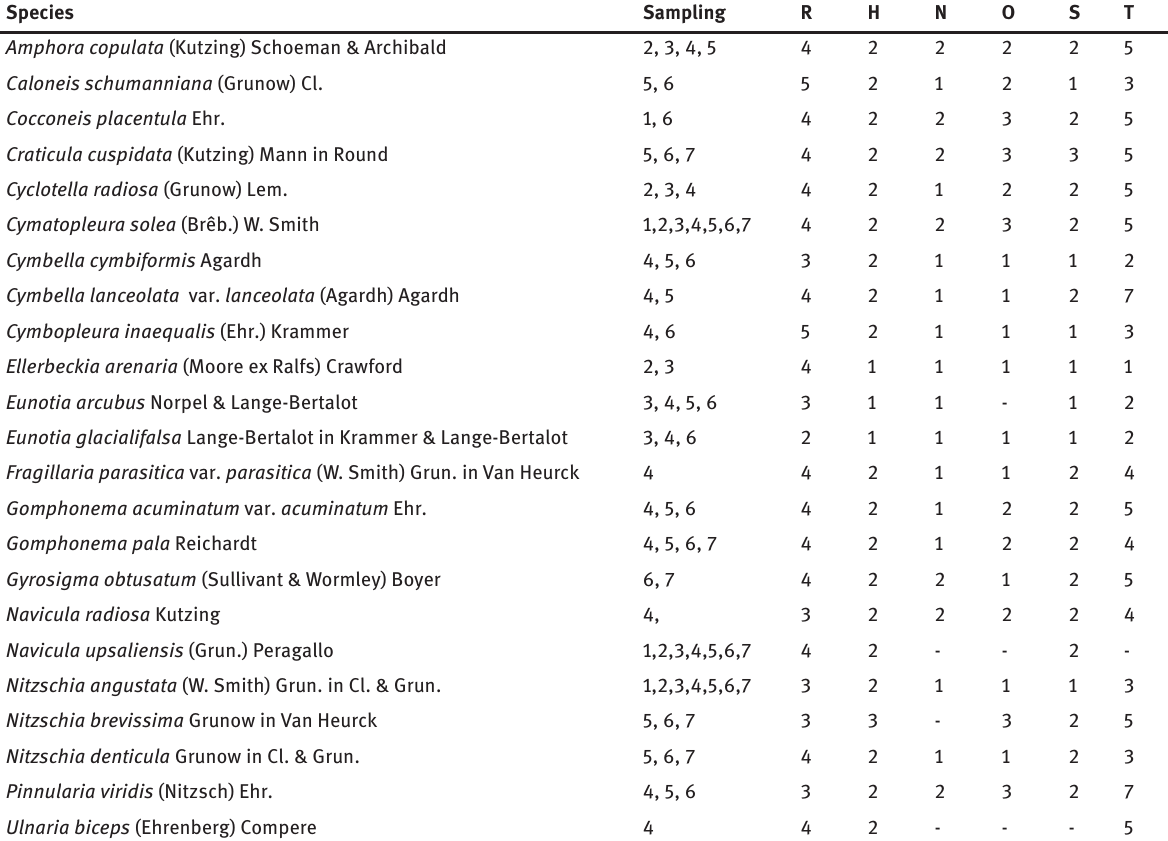
Table 4 : Ecological characteristic of diatoms acc. [5] most often found in Trzuskawica S.A in 2015. Explanation: sampling i.e. : water biotops 1-7 (see Figs 1-2). pH (R): acidophilous (2), circumneutral (3), alkaliphilous (4), alkalibiontic (5). Salinity (H): fresh (1), fresh brackish (2), brackish fresh (3). Nitrogen uptake metabolism (N): nitrogen-autotrophic taxa (1), nitrogen-autotrophic taxa (2). Oxygen requirements (O): continuously high (1), fairly high (2), moderate (3). Saprobity (S): oligosaprobous (1), p-mesosaprobous (2), α-mesosaprobous (3). Trophic state (T):